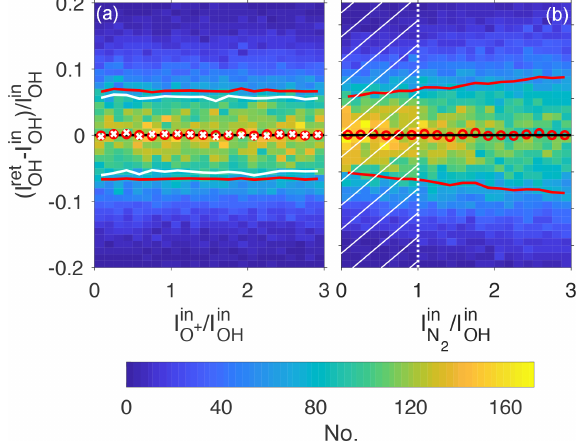
Figure 7. 2-D histograms of errors on the retrieval of OH inten- sity as a function of the ratio of O + to OH intensity (a) and as a function of the ratio of N 2 to OH intensity (b) . Red circles indicate mean values and red lines are 1 standard deviation on either side of the mean. The white crosses and lines in panel (a) represent the mean and 1 standard deviation from the mean when only taking into account spectra with N 2 intensity in the hatched area in panel (b)